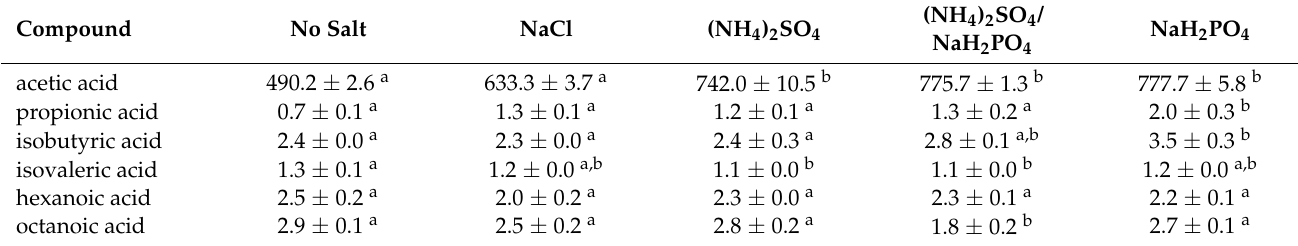
Letters indicate significant differences between the extraction extent for each analyte using different